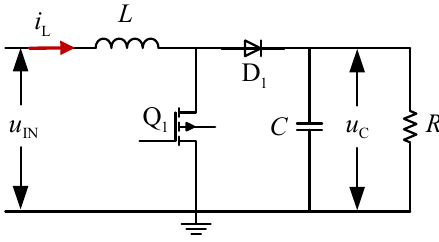
Figure 1. Load analog boost circuit diagram.